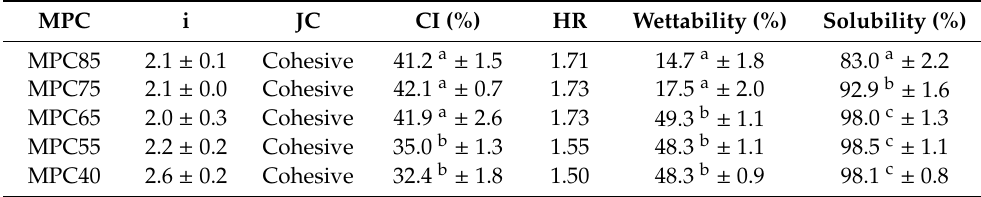
Table 3. Flow and rehydration (wettability and solubility) properties of milk protein concentrate (MPC)